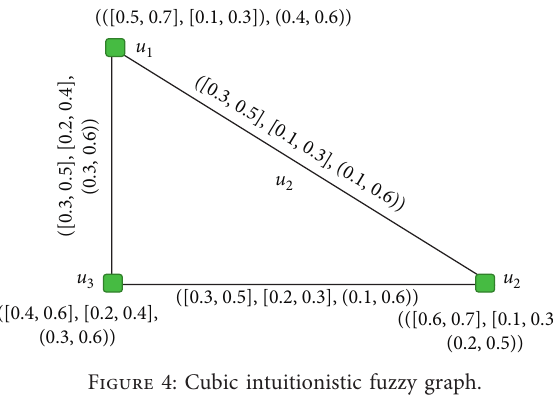
Figure 4: Cubic intuitionistic fuzzy